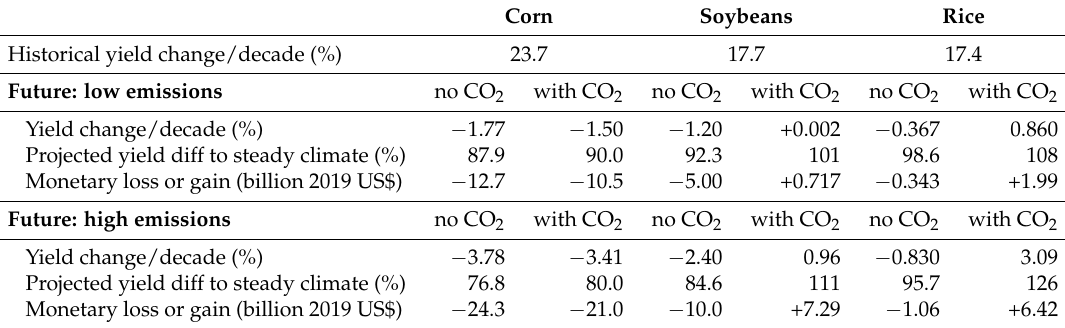
Statistics on future yield predictions, for forecasts without and with CO 2 fertilization. Future yield change per decade are in comparison to expected yields without climate change. Monetary losses are calculated from the acres harvested and the crop prices in 2016